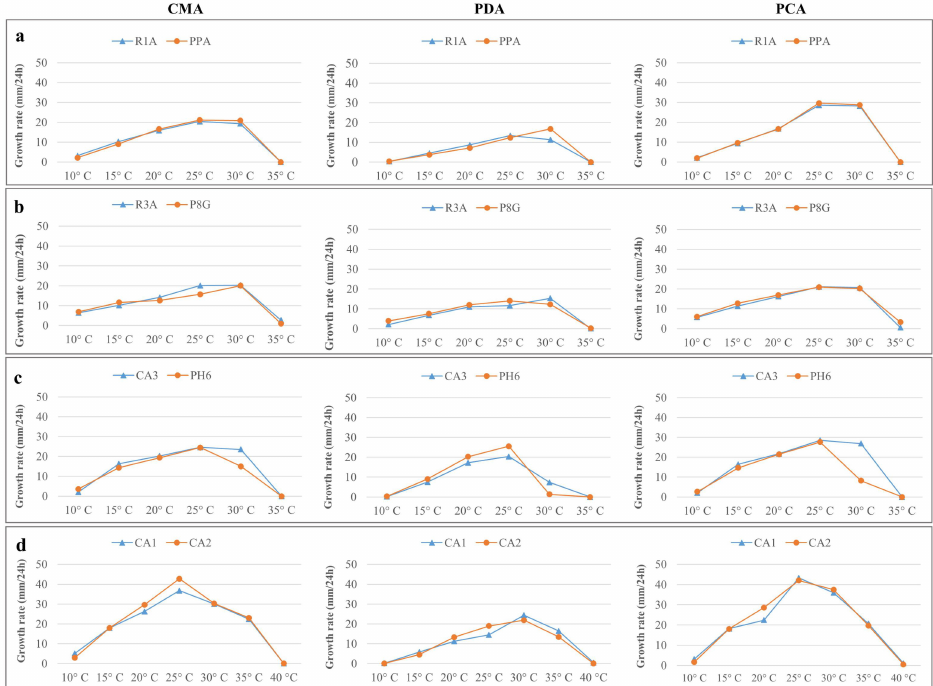
Figure 4. Average radial growth rate (mm/24 h) of Phytopythium species grown onto CMA, PDA and PCA media at different temperatures for 5 days. ( a ) P. vexans strains R1A and PPA; ( b ) P. litorale strains R3A and P8G; ( c ) P. chamaehyphon strains CA3 and PH6; ( d ) P. helicoides strains CA1 and CA2.